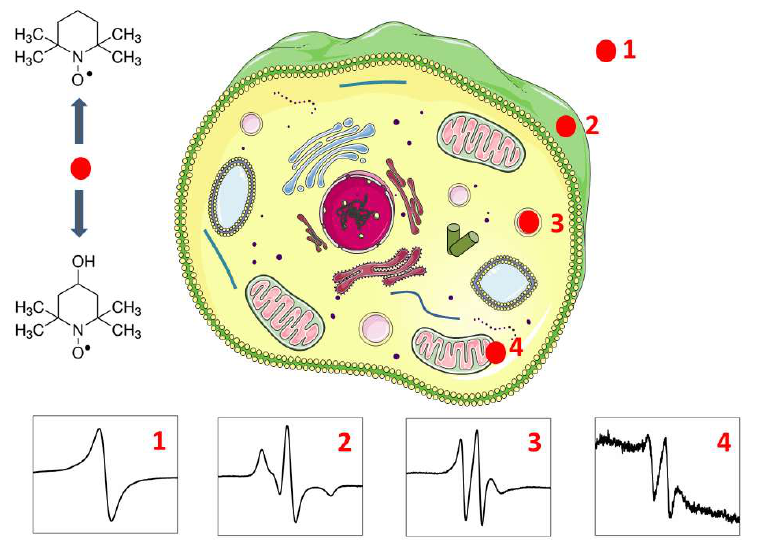
Figure 3. Schematic representation of possible spin probe location based on ESR spectrum shape of TEMPO or TEMPOL with yeast cells recorded at 240 K: 1—spin probe outside cells, 2—spin probe attached to a cell, 3—spin probe inside cells, 4—spin probe inside cells (probably in cellular mitochondria). The figure was created using Servier Medical Art templates, licensed under a Creative Commons Attribution 3.0 Unported License; https://smart.servier.com (accessed on 16 December 2019).